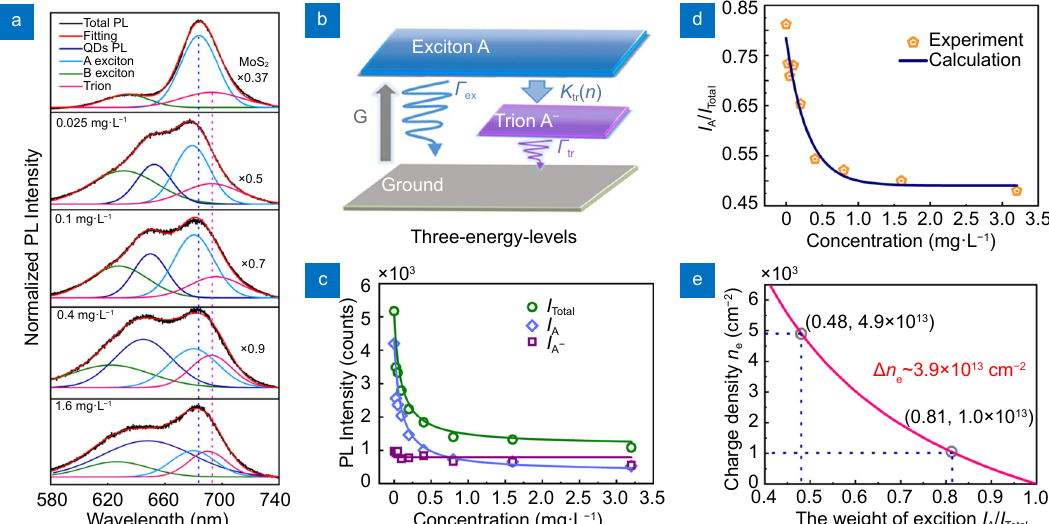
Fig. 3 | Analysis of PL spectral evolution of heterostructures at various doping densities. ( a ) Normalized PL spectra of QD/MoS 2 hetero- structures with different QD concentrations. The total PL spectra (red) can be fitted well with several components, involving QD exciton (dark blue), MoS 2 exciton A (blue), trion (pink) and exciton B (green). ( b ) Schematic view of the three-energy-levels including exciton, trion and ground states, where the trion is generated from the exciton. ( c ) Diagram of PL intensity of total intensity ( I Total ), exciton ( I A ) and trion ( I A- ). Fitting curves match well with experimental results. ( d ) The weight ratio of exciton ( I A / I Total ) as a function of concentration. ( e ) Calculations of charge density ( n e ) based on the law of mass action model. The electron density of charge transfer ( Δn e ) is determined as 3.9×10 13 cm −2